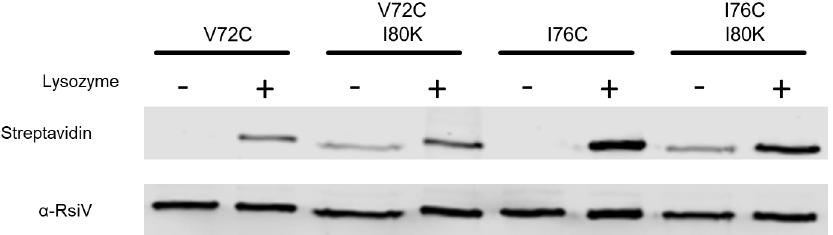
Fig 6. Lysine substitution disrupts the membrane association of hydrophobic residues. To determine the effect of lysine substitution on hydrophobic residue accessibility in the amphipathic helices we created a construct with